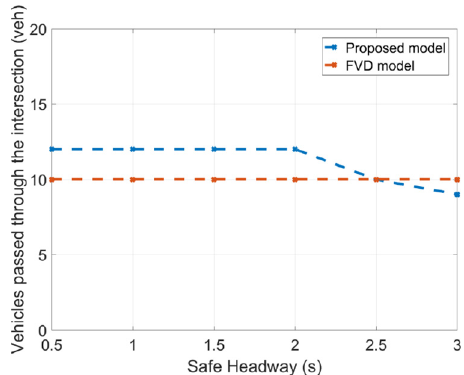
Figure 3 Effect of safe headway